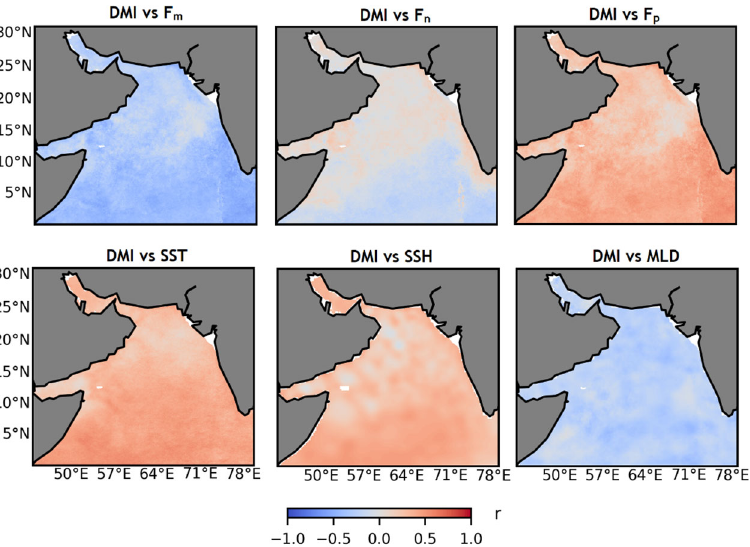
Figure 7. Correlation between the Indian Ocean–Dipole Mode Index and monthly anomalies of size fractioned chl − a (F m , F n , F p ), SST, SSH, and MLD. The correlations of DMI vs. PSC, SST, SSH, and MLD are statistically significant ( p < 0.05).